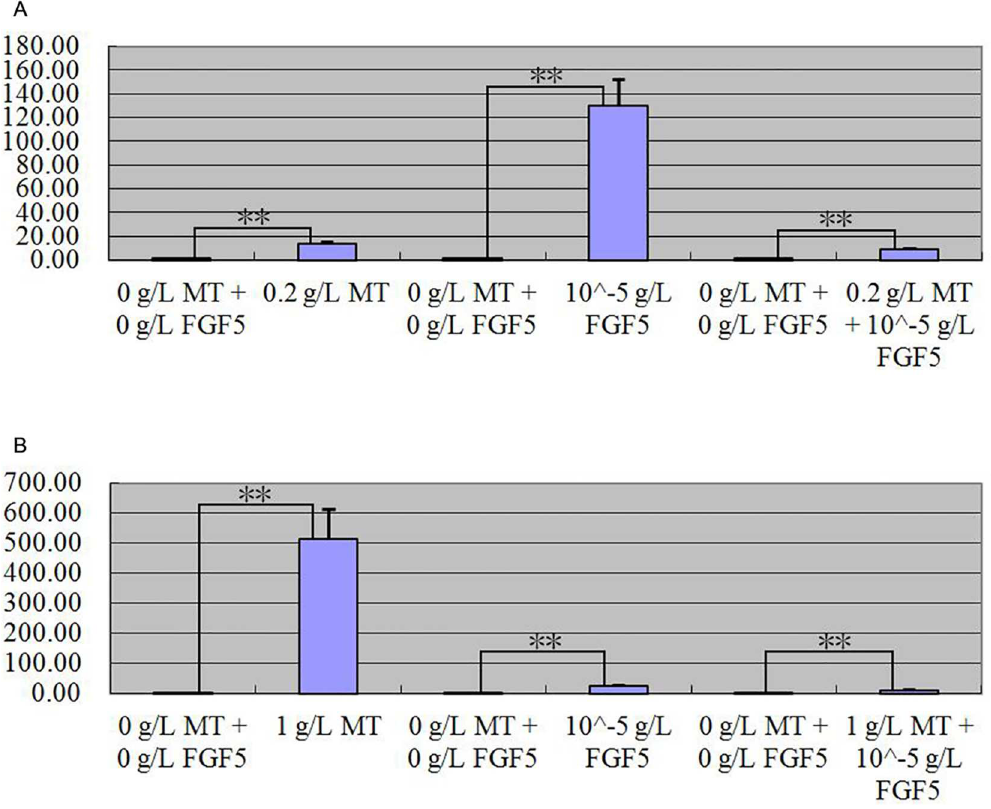
Fig 11. Expression quantity change of keratin 26 after 0.2 g/L MT and 10 − 5 g/L FGF5 treatment together for 24 h or 1 g/L MT and 10 − 5 g/L FGF5 treatment together for 72 h was detected by quantitative real-time PCR. Fig 11A. Expression quantity of keratin 26 was 13.21 × (p < 0.01) greater in the groups which cells were treated with 0.2 g/L MT than the group which cells were treated with 0 g/L MT for 24 h, 129.91 × (p < 0.01) greater in the groups which cells were treated with 10 − 5 g/L FGF5 than the group which cells were treated for 0 g/L FGF5 for 24 h, 9.09 × (p < 0.01) more in the group which cells were treated with 0.2 g/L MT and 10 − 5 g/L FGF5 together than the group which cells were treated with 0 g/L FGF5 and 0 g/L MT for 24 h. Fig 11B. Expression quantity of keratin 26 was 513.36 × (p < 0.01) greater in the groupswhich cells were treated with 1 g/L MT than the group which cells